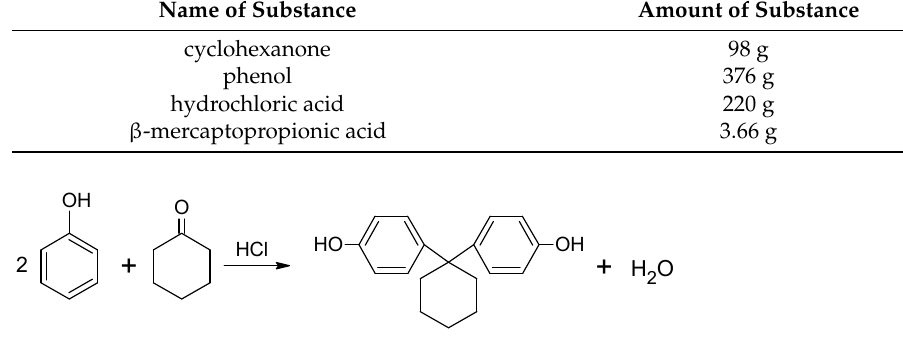
Figure 2. Reaction scheme for the synthesis of bisphenol Z.